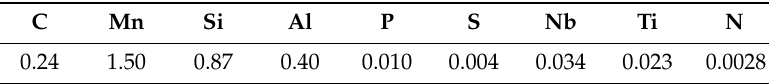
Table 1. Chemistry of the alloy in